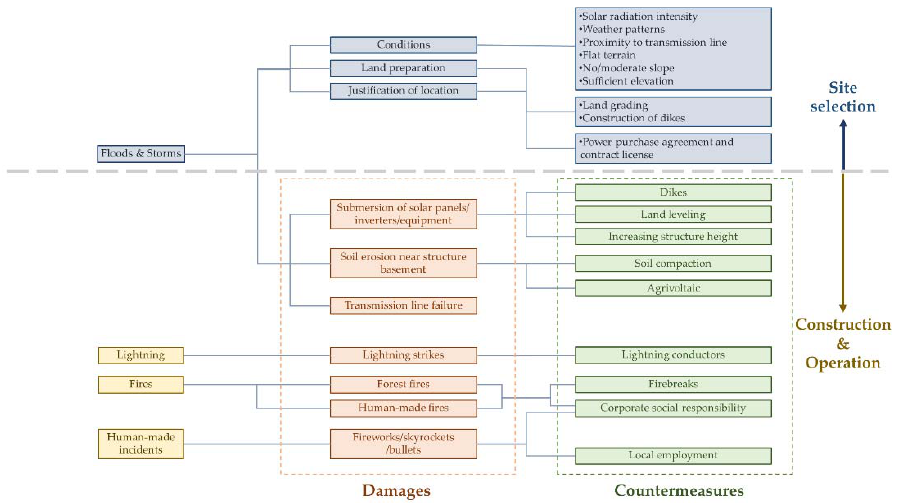
Figure 3. Key insights from thematic analysis on climate risks, countermeasures, and points of consideration during location selection.